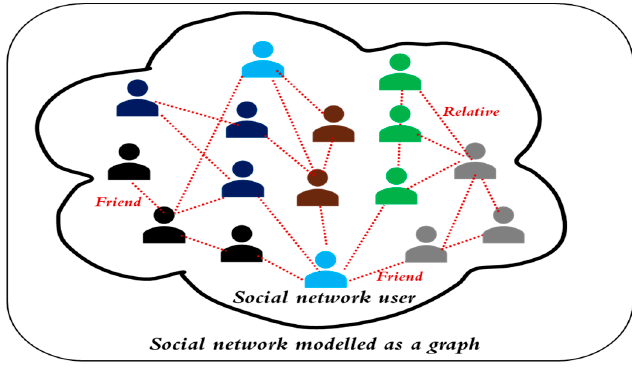
Figure 22. Social network (SN) users modelled as a graph G .